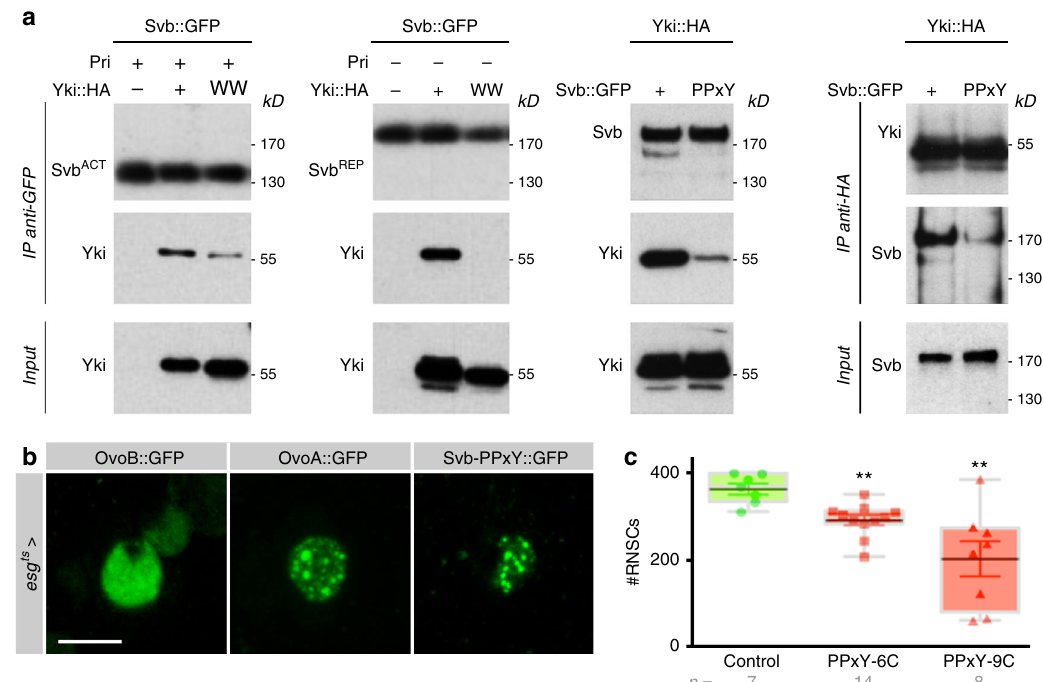
Fig. 7 The Svb and Yki proteins associate to maintain RNSCs. a Co-immuno-precipitation of Svb with Yki. Svb::GFP and Yki::HA were expressed in S2 cells, with or without Pri peptides, and protein extracts were immuno-precipitated using anti-GFP (left panels) or anti-HA antibodies (right panel). Point mutations substituting the WW domains of Yki (YkiWW::HA), or the PPxY motifs of Svb (Svb-PPxY::GFP), prevent Svb/Yki physical interaction. b Intra- nuclear distribution of the constitutive activator (OvoB), or repressor (OvoA) forms of Svb within RNSCs. Svb-PPxY displays a pattern of nuclear foci distribution, evoking that of the dominant negative form of Svb (OvoA). c Consequences of Svb-PPxY expression in adult RNSCs (driven by esg ts -Gal4 ). Two different genomic insertions allowing the expression of Svb-PPxY::GFP (#6C and #9C) decrease the number of renal stem cells ( p = 0.0059 and 0.0023). Values are presented as average ± standard error of the mean (SEM) and boxes with whiskers (10 – 90 percentile), p -values from Mann – Whitney test (** p < 0.01). Scale bar is 3 µ m